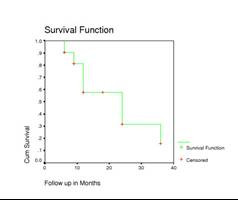
Corneal graft survival.